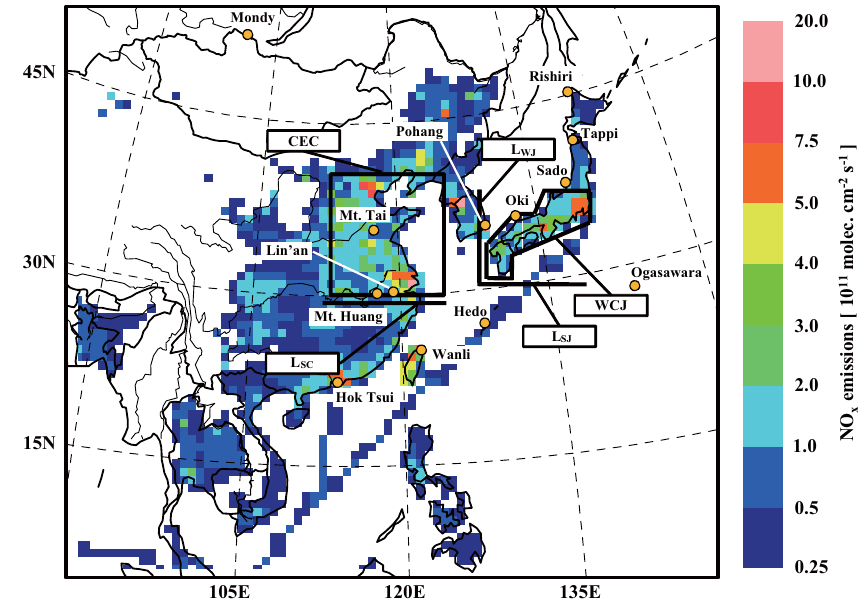
Fig. 1. Model domain of CMAQ showing the horizontal distribution of REAS NO x emissions for 2000. The box labeled WCJ denotes western and central Japan, the focal area of our analysis of the IAV of springtime BL O 3 . The lines L WJ and L SJ are respectively defined as the western and southern boundaries of WCJ, along which we calculated the BL O 3 fluxes. The box labeled CEC denotes central eastern China, and line L SC is defined as the southern boundary of CEC for the calculation of BL O 3 fluxes. The locations of O 3 monitoring sites used for model validation in Sect. 3.1 are also shown as orange circles.